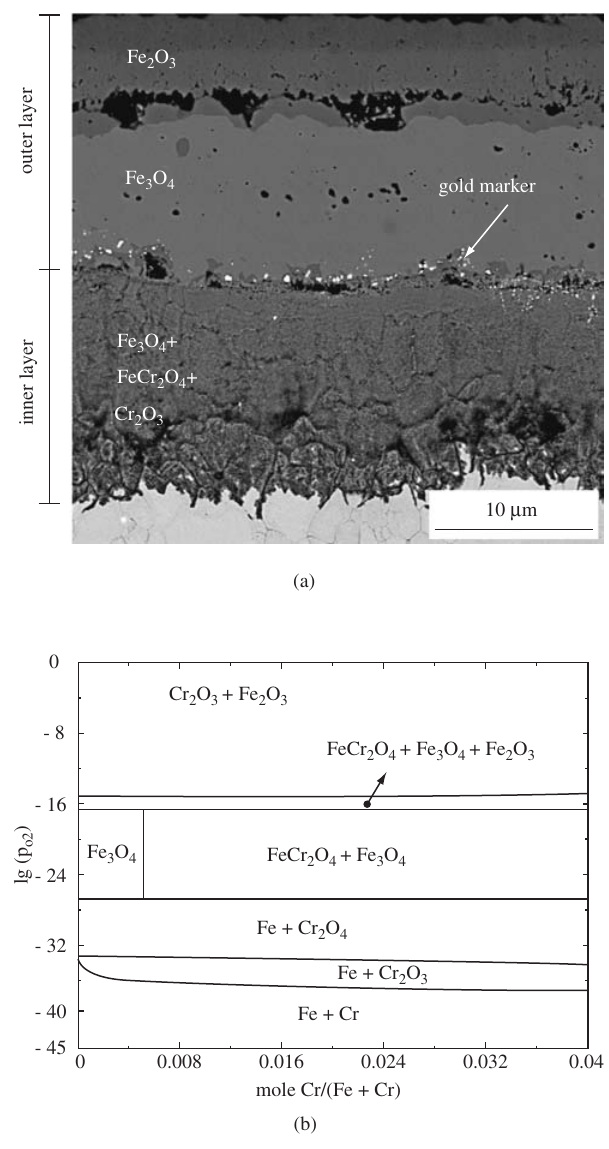
Figure 1. a) Oxide scale formed on the low-alloy steel 2.25Cr1Mo after expo- sure to laboratory air at 550 °C for 72 hours; and b) influence of low Cr com- positions on the oxide phase stabilities in the Fe-Cr-O